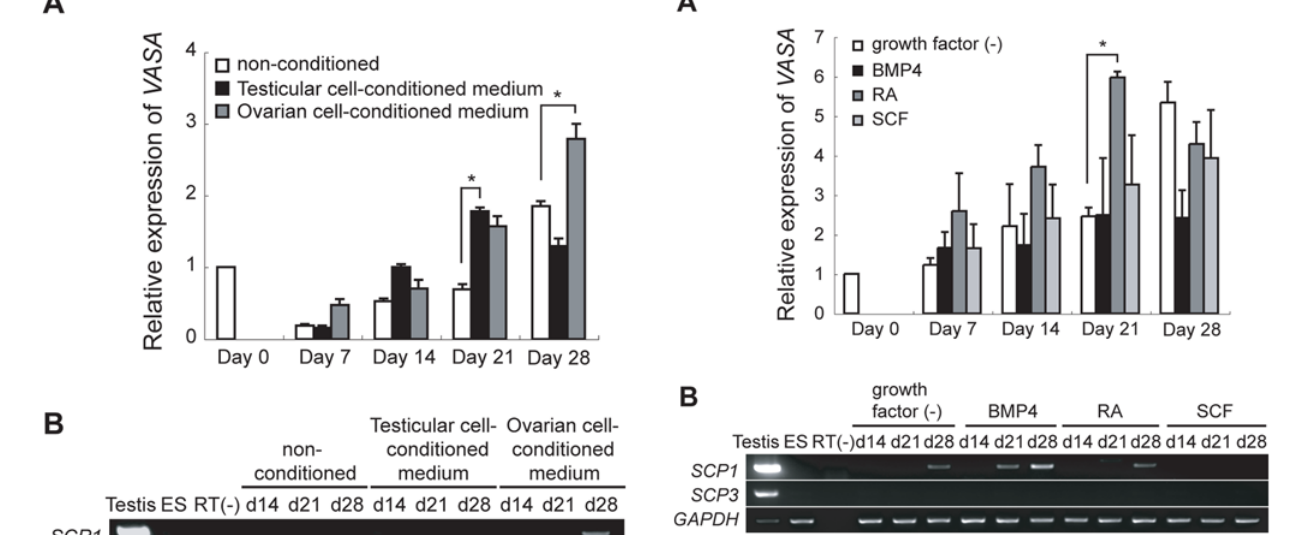
Figure 5. The effect of BMP4, RA and SCF on germ cell differentiation in monkey EBs. ( A ) VASA expression in EBs cultured in the presence or absence of BMP4 (100 ng/ml), RA (1 m M), and SCF (100 ng/ml) was compared using quantitative RT-PCR. The expression levels of VASA in treated EBs are shown relative to VASA expression in ES cells (day 0). The data represent the means 6 standard deviation from triplicate PCR assays. ( B ) The expression of SCP1 and SCP3 in monkey testis (5 years old), ES cells (ES), and developing EBs (days 14, 21, and 28) in the presence or absence of BMP4 (100 ng/ml), RA (1 m M), and SCF (100 ng/ml) was examined using RT-PCR. GAPDH was used as an internal control. Statistical significance was tested by Student’s t -test. Asterisk, P ,